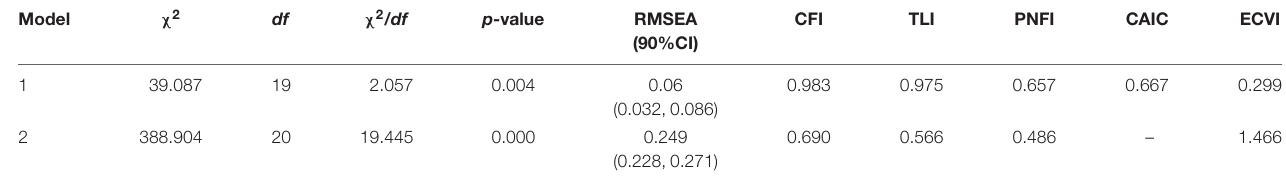
TABLE 5 | The fit indices for two competing confirmatory factor analytic models of the COIQ (testing Hypothesis 1 , Study 2, N = 299). Model